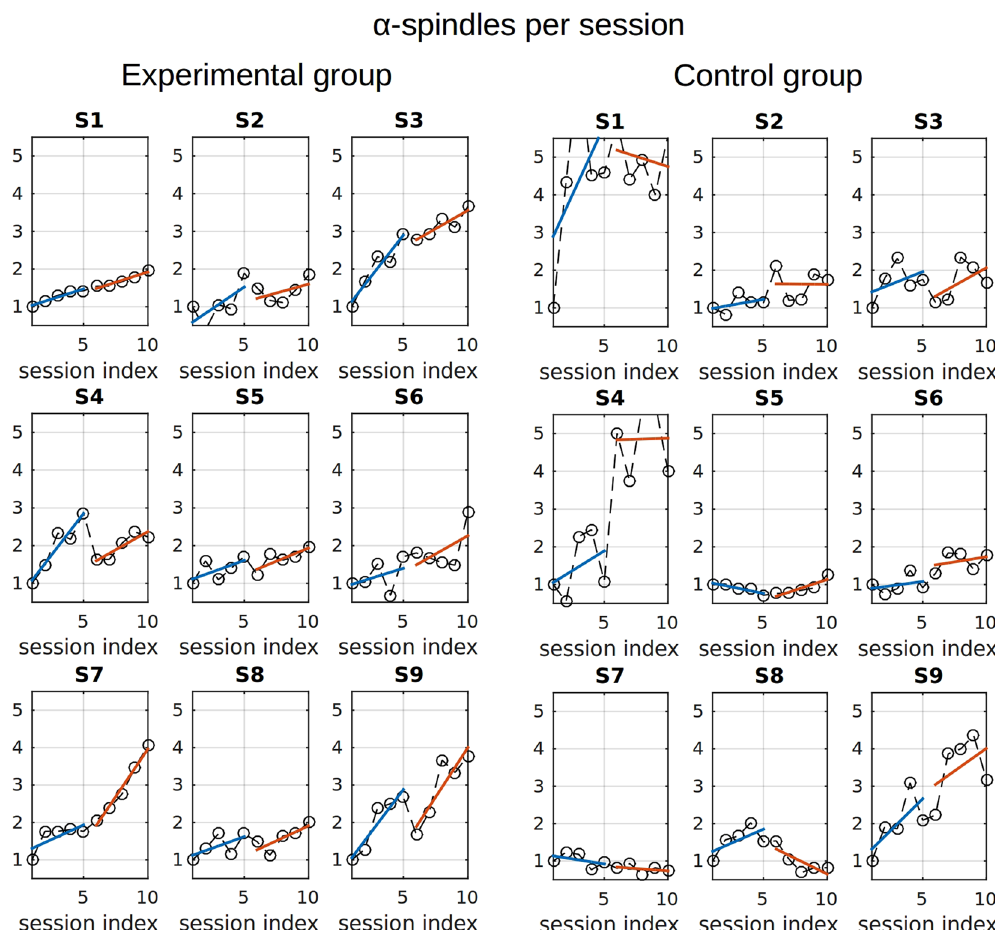
Figure 7. The dynamics of alpha-spindles incidence rate as a function of the training segment index (1–10) for all subjects (n = 9 experimental, n = 9 control) groups. The first five segments correspond to the the first day and the last five to the second day of training. For each subject, we normalized the spindles count by the number of events observed in the 1st segment (first day). The top panel corresponds to the experimental group and the bottom panel represents the data for the control group. All the subjects from the experimental group exhibit reliable positive correlation of within day training segment index. For quantification of the between group effects see Figure